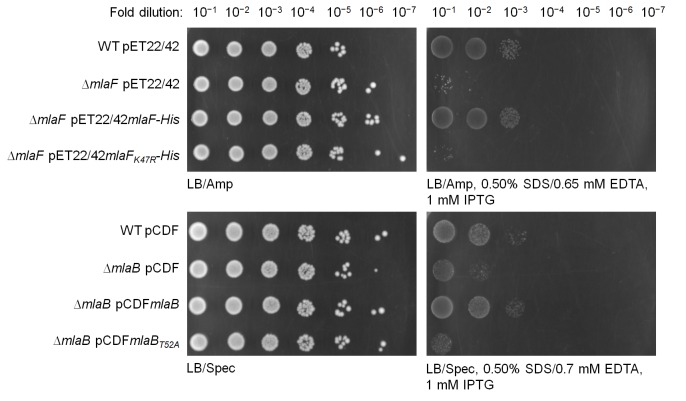
mlaFK47R and mlaBT52A are non-functional alleles.Serial dilutions of cultures of wild-type (WT) and ∆mlaF strains harboring pET22/42 empty vector, pET22/42mlaF-His or pET22/42mlaFK47R-His, or WT and ∆mlaB strains harboring pCDF empty vector, pCDFmlaB or pCDFmlaBT52A were spotted on LB agar plates containing appropriate antibiotics, supplemented with or without 0.50% SDS, 0.65/0.70 mM EDTA as indicated, and incubated overnight at 37°C. The strains used here do not express T7 polymerase. IPTG (1 mM) was added to allow de-repression and thus low-level transcription (by endogenous polymerases) from the T7-lacO promoter in these plasmids.